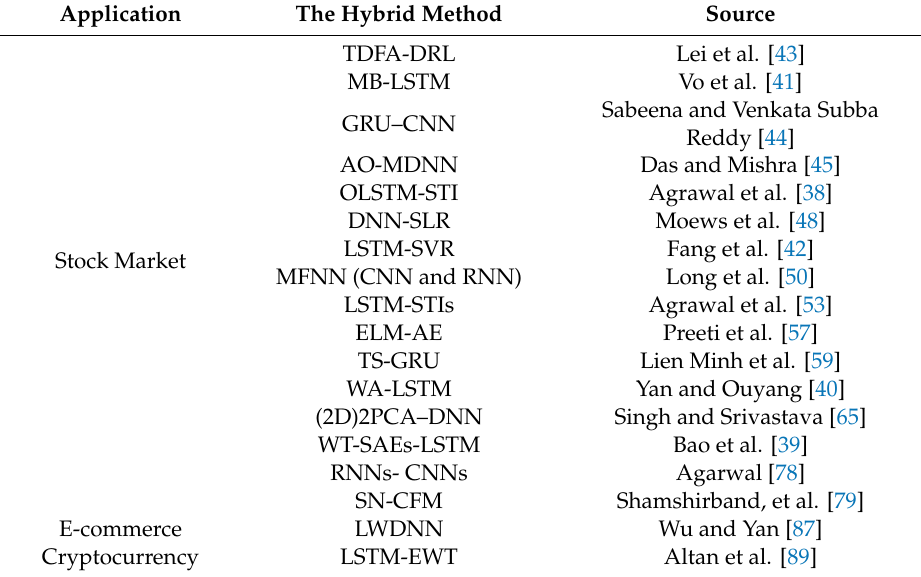
Table 9. List of hybrid deep learning models employed in economic related fields.